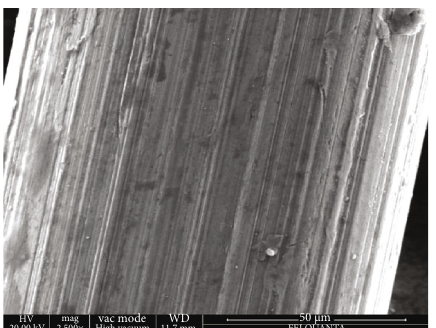
Figure 6: SEM image of Ni-Chrome wire